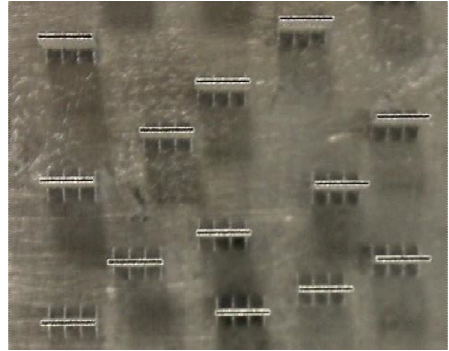
Figure 3. Ti6Al4V thin-walled tubes after SLM fabrication.